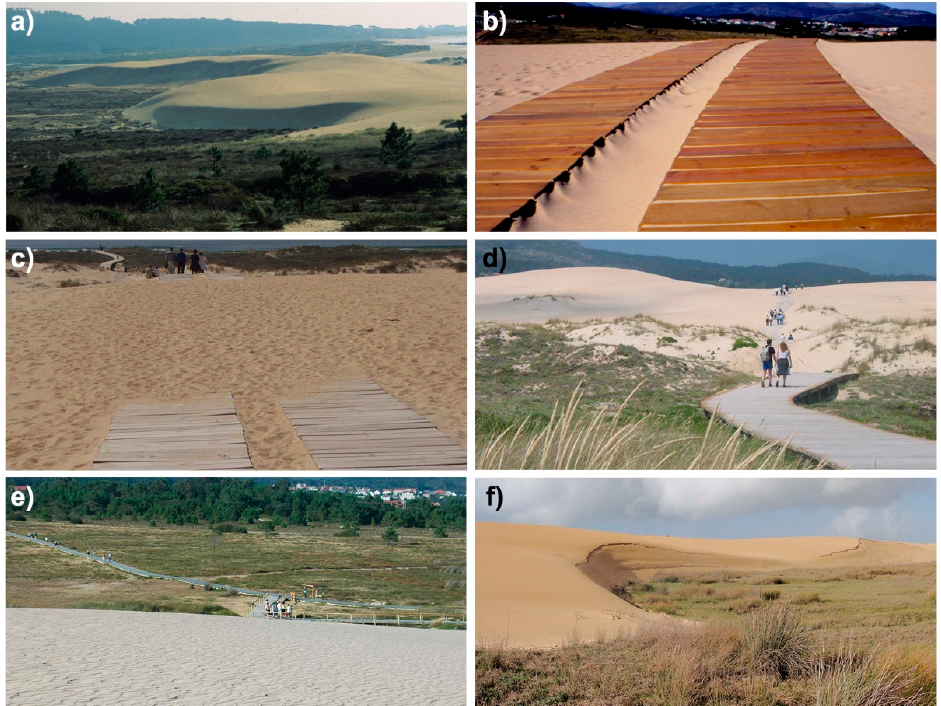
Figure 10. Evolution of large shifting dune sector in different moments. ( a ) shows the dune sector in 1992; ( b ) shows the walkway in early 2000; ( c ) shows the walkway in 2002 cover in part for the dune evolution; ( d ) shows visitants in the walkway across the dune in 2002; ( e ) reveals the ripples in the dune zone and the new walkway position, without the across dune section in 2006; and ( f ) shows the state of large shifting dune in the sector close to the walkway in 2012, that clearly repre- sent their progression.